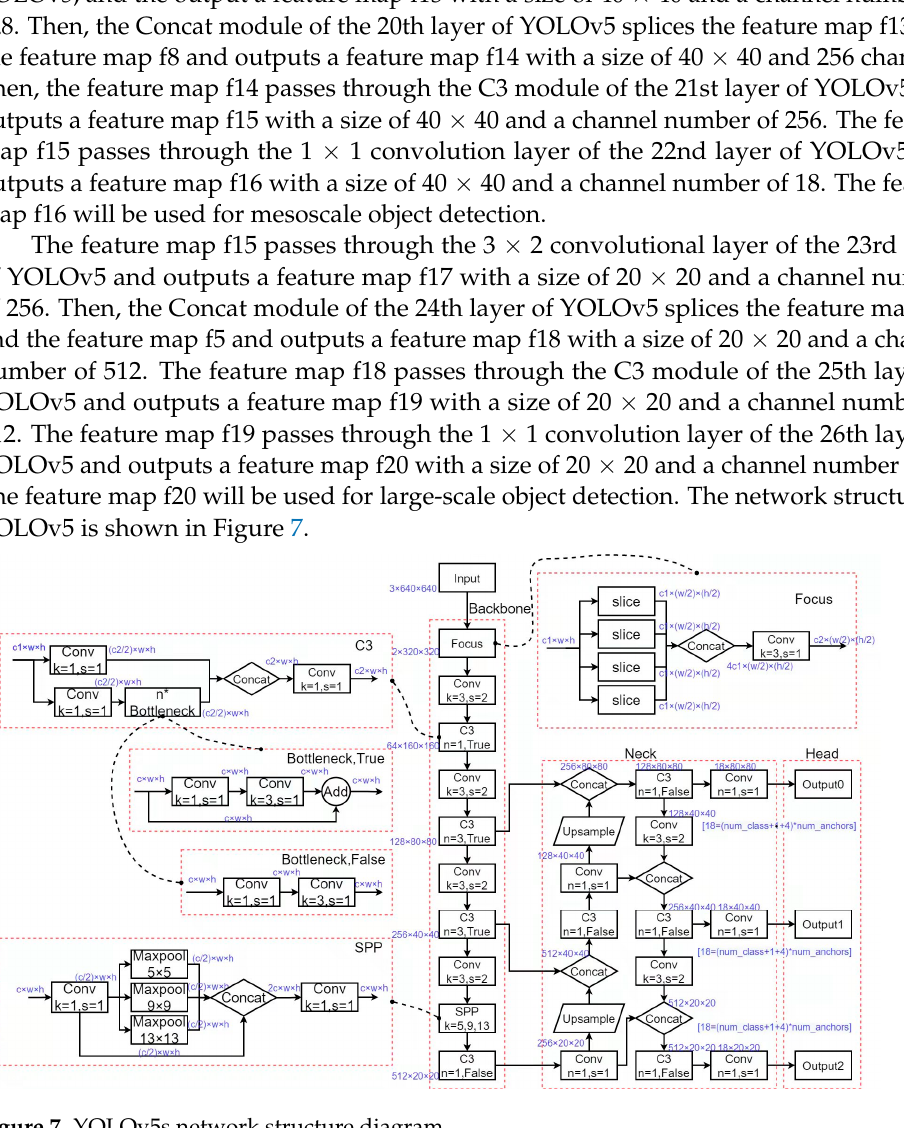
Figure 7. YOLOv5s network structure diagram.